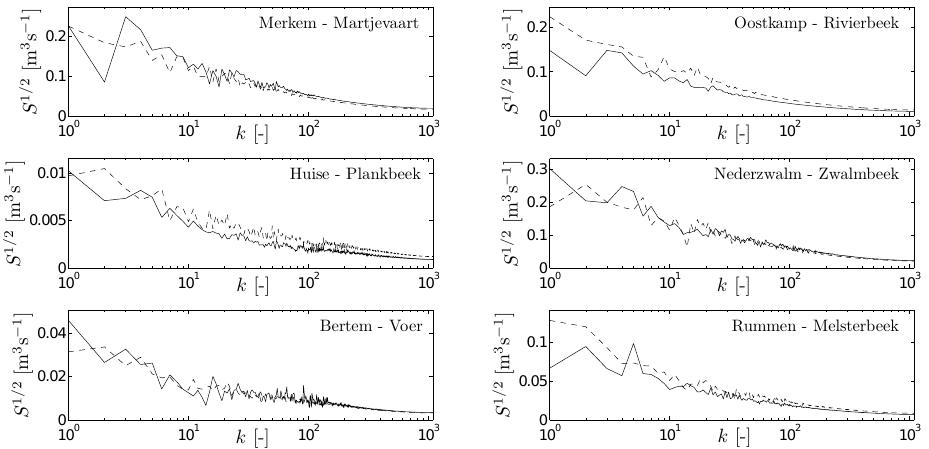
Fig. 6. Actual (solid line) vs. estimated (dashed line) root squared density spectrum ( k > 0) of the discharge time series for the six au- tochthonous catchments in the case of temporal gauging divergence (period 2006–2007). The estimates are root squared densities of the autochthonous discharge time series during the period 2008–2009.